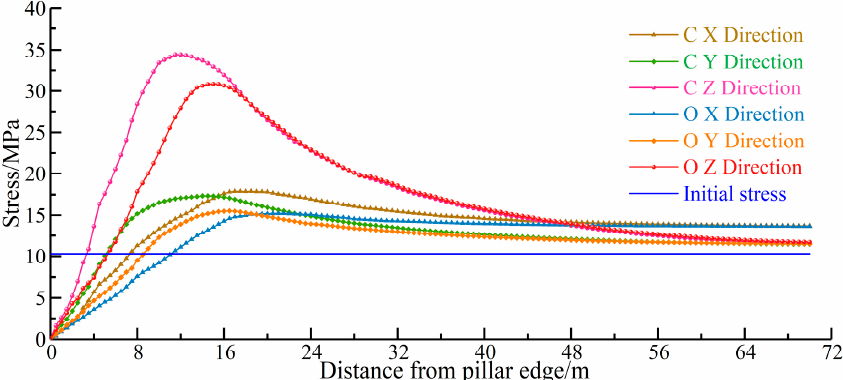
Figure 13. Lateral stress distribution curves after pressure relief by roof cutting.